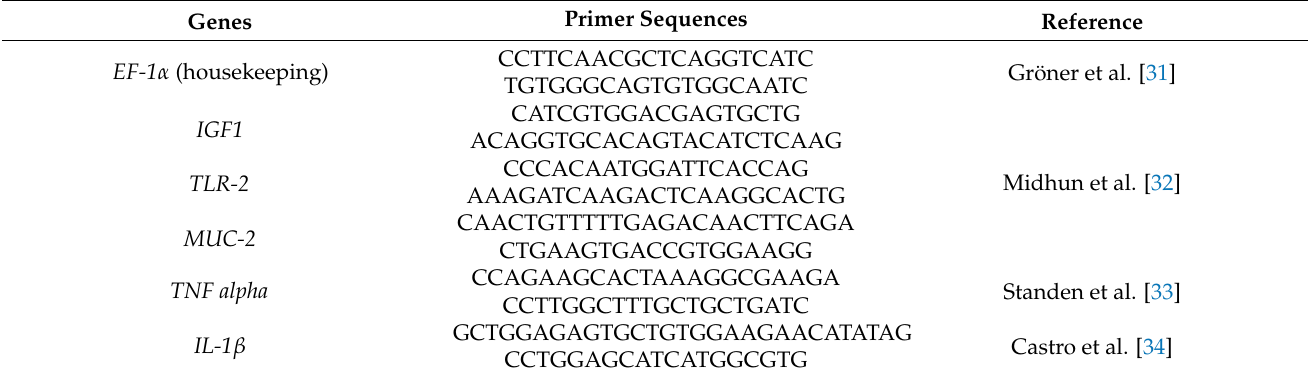
Table 3. Primer sequences and target genes for SYBR Green